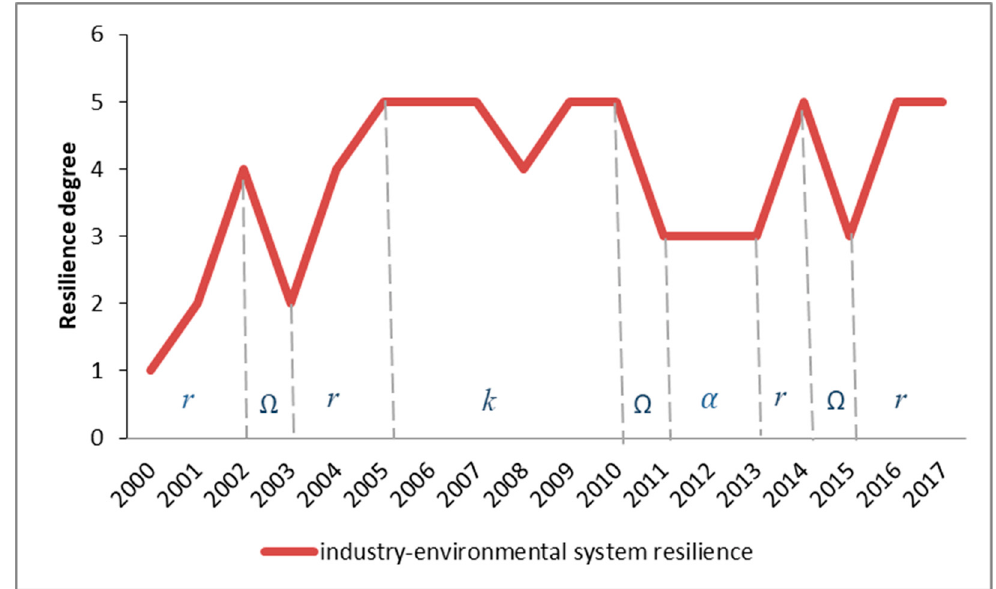
Figure 7. Resilience grades changes of the industry–environmental system.